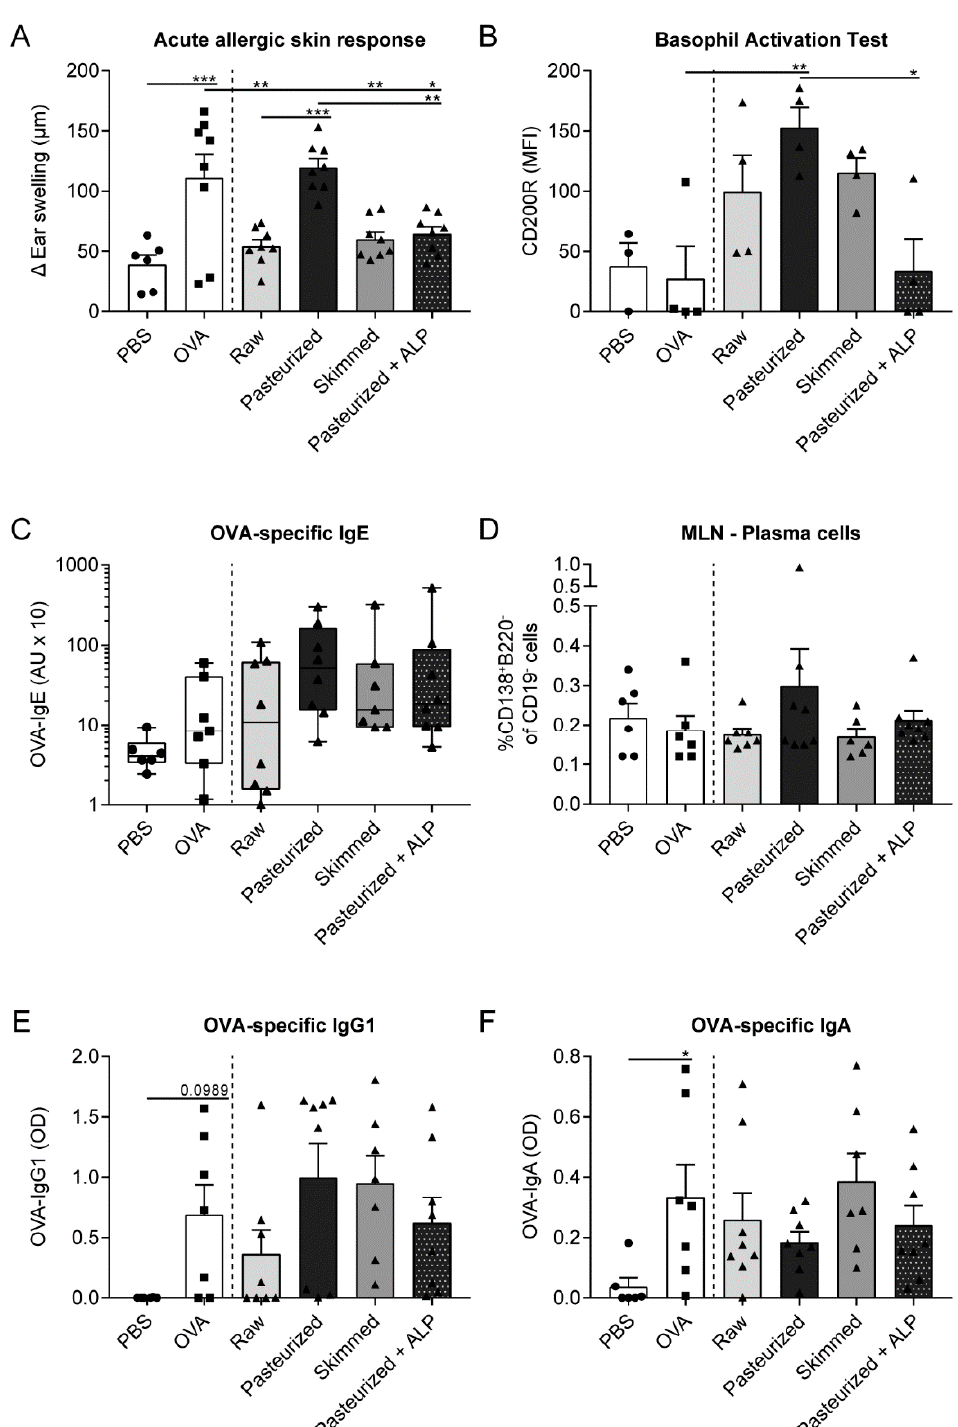
Figure 2. The protective effect of raw milk on the allergic effector response is retained by skimming but abolished by pasteurization of the milk. ( A ) The acute allergic skin response, expressed as Δ ear swelling, measured after intradermal challenge in the ear pinnae of both ears with OVA. ( B ) Basophil activation determined at Day 27 by surface expression of CD200R upon stimulation of whole blood with OVA (after subtracting baseline basophil activation). ( C ) Serum OVA-specific IgE levels measured 16 h after oral challenge. ( D ) Plasma cell (CD138 + B220 − of CD19 − cells) frequency assessed in the MLN. ( E ) Serum OVA-specific IgG1 and ( F ) IgA levels measured 16 h after oral challenge. Data are presented as mean ± SEM or as box-and-whisker Tukey plot when data were not normally distributed. In addition, individual data points are displayed, n = 6 in PBS group and n = 6–8 in all other groups. For the basophil activation test ( B ), blood samples from two mice were pooled, n = 3 in